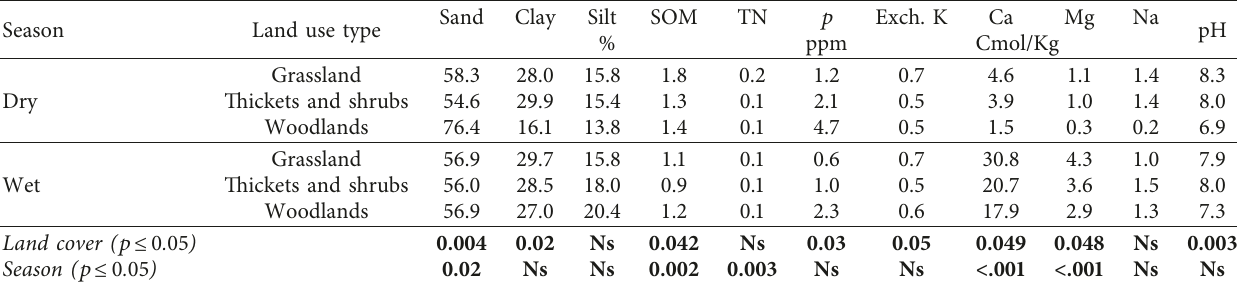
Table 6: Effects of land cover type on physical and chemical soil properties at 15–30 cm depth.